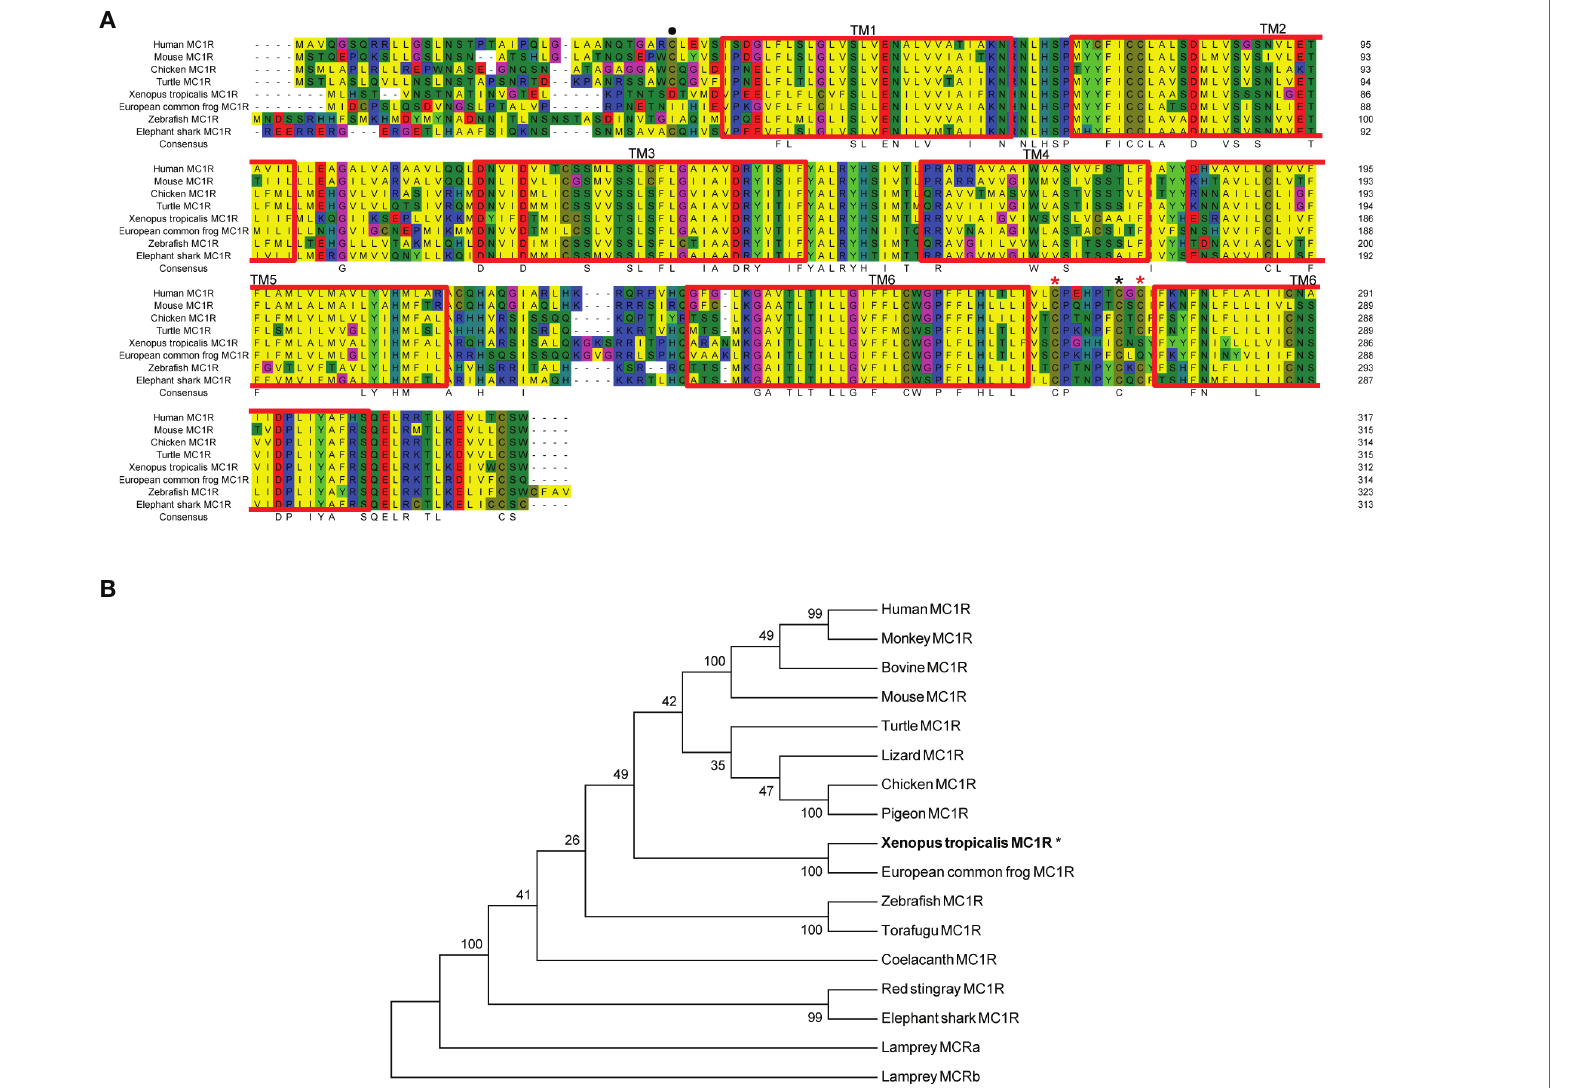
FIGURE 1 | Protein alignment and phylogenetic analysis of Xenopus tropicalis Mc1r. (A) Sequence alignments of xtMc1r (XP_012817790.1) and other Mc1rs from human (NP_002377.4), mouse (NP_032585.2), monkey (NP_032585.2), bovine (NP_776533.1), chicken (NP_001026633.1), pigeon (OPJ78282.1), turtle (XP_005308247.1), European common frog (ACA28876.1); zebra fi sh (NP_851301.1), torafugu (AAO65548.1), coelacanth (XP_005999265.1), red stingray (BAU98230.1), elephant shark (ENSCMIT00000036457.1), lamprey Mca receptor (XP_032816350.1), and lamprey Mcb receptor (ABB36647.1).The blue, red, and yellow represent a homology over 50%, 75%, and 100%, respectively. (B) Dendrogram of Mc1rs was generated by the NJ analysis with Molecular Evolutionary Genetics Analysis (MEGA) software. Asterisk (*) indicates xtMC1R with bold